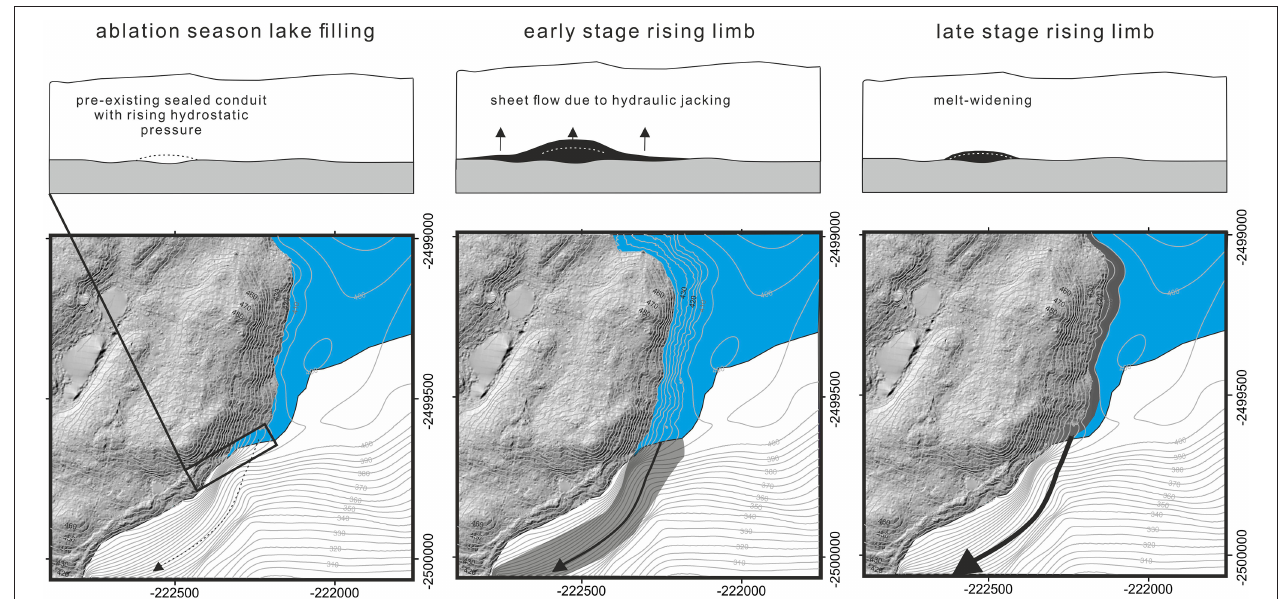
FIGURE 10 | Schematic to illustrate evolution of ice-dammed lake water level and subglacial conduit to explain lake drainage mechanisms. Arrows denote likely subglacial conduit pathway. Contours denote bed elevation.